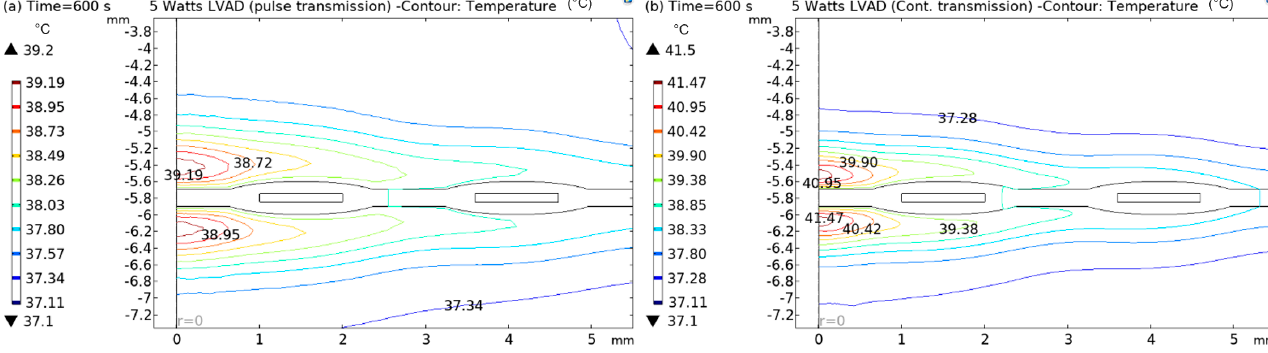
Figure 14. Contour plots of thermal analysis: ( a ) pulsed and ( b ) continuous transmission modes for 5 W LVAD.